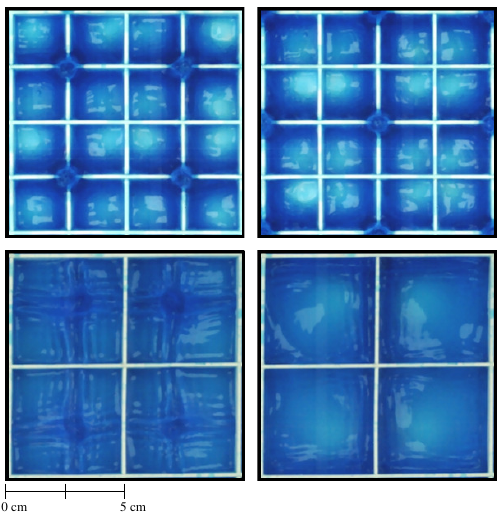
Figure 3. Top view images of a portion of the grid showing the resulting patterns at F = 10 Hz for cells of size l = 2.5 cm ( A = 2 mm; top images ) compared to those resulting for cells of size l = 5 cm ( A = 1.4 mm; bottom images